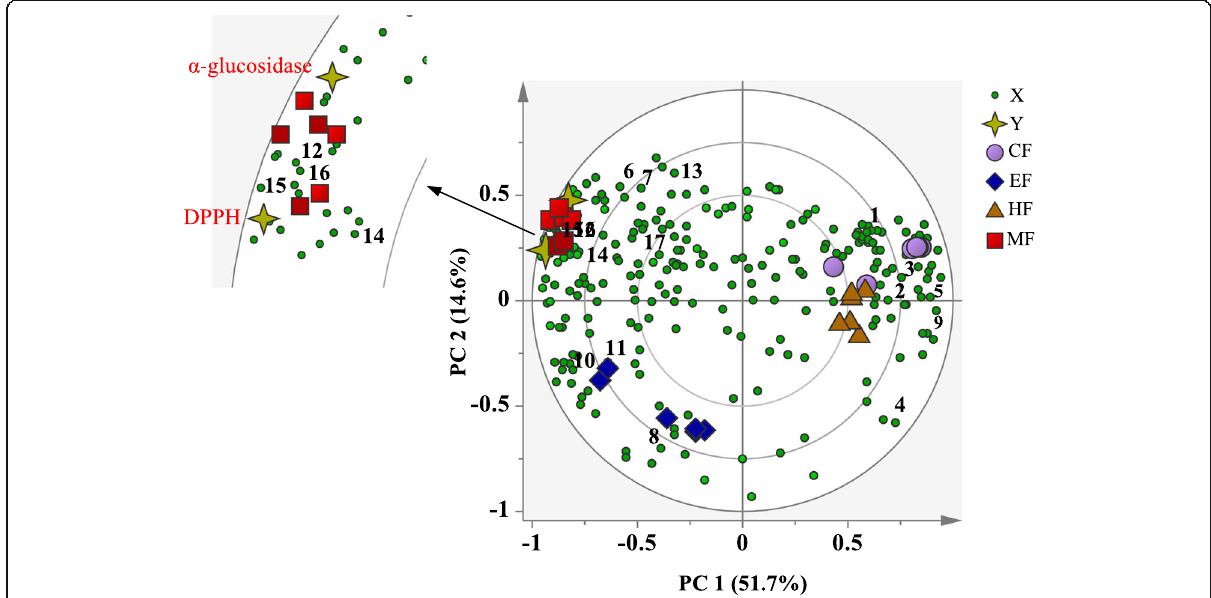
Fig. 5 The PLS biplot of different fractions of N. oleracea . HF, hexane fraction; CF, chloroform fraction; EF, ethyl acetate fraction; MF, methanol fraction; 1, phytosterol; 2, fatty acids; 3, alanine; 4, leucine; 5, valine; 6, α -glucose; 7, β -glucose; 8, fructose; 9, oleanolic acid; 10, quercetin derivatives; 11, kaempferol derivatives; 12, apigenin derivatives; 13, myricetin derivatives; 14, gallic acid; 15, 3,4- O -dimethylgallic acid; 16, caffeic acid; 17,